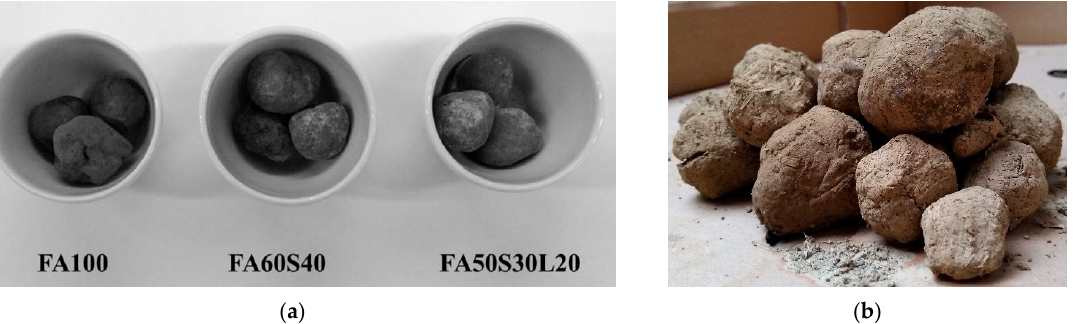
Figure 3. ( a ) Granular fertilizer (10 mm diameter) prepared by Pesonen et al. [78] with 100% fly